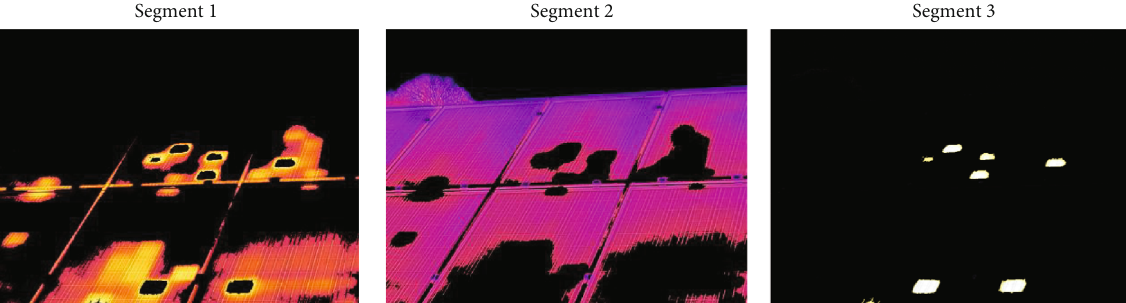
Figure 11: Output results using K-means algorithm for k = 3 .